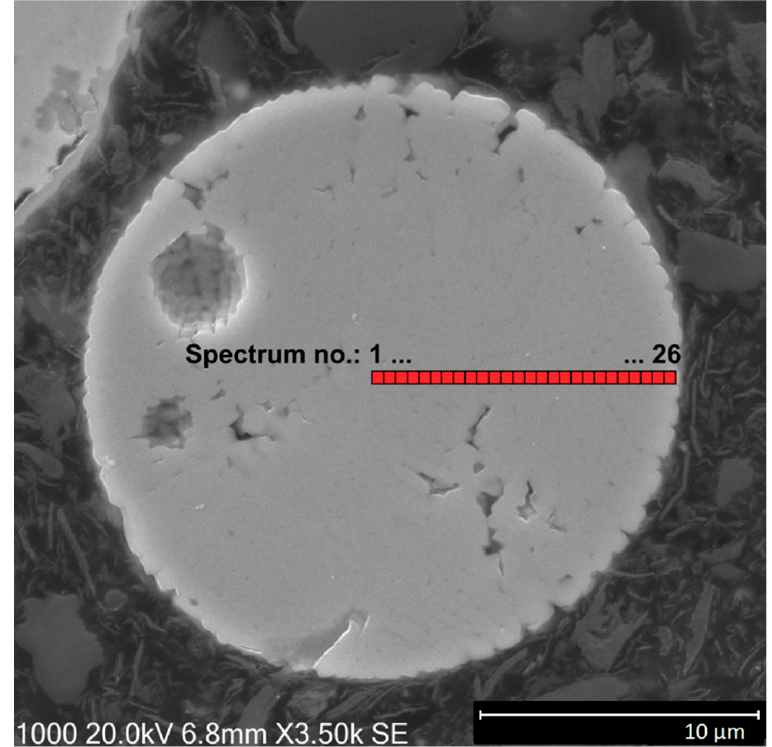
Figure 7. Microparticle cross-section with highlighted areas from which the EDS spectra were taken.